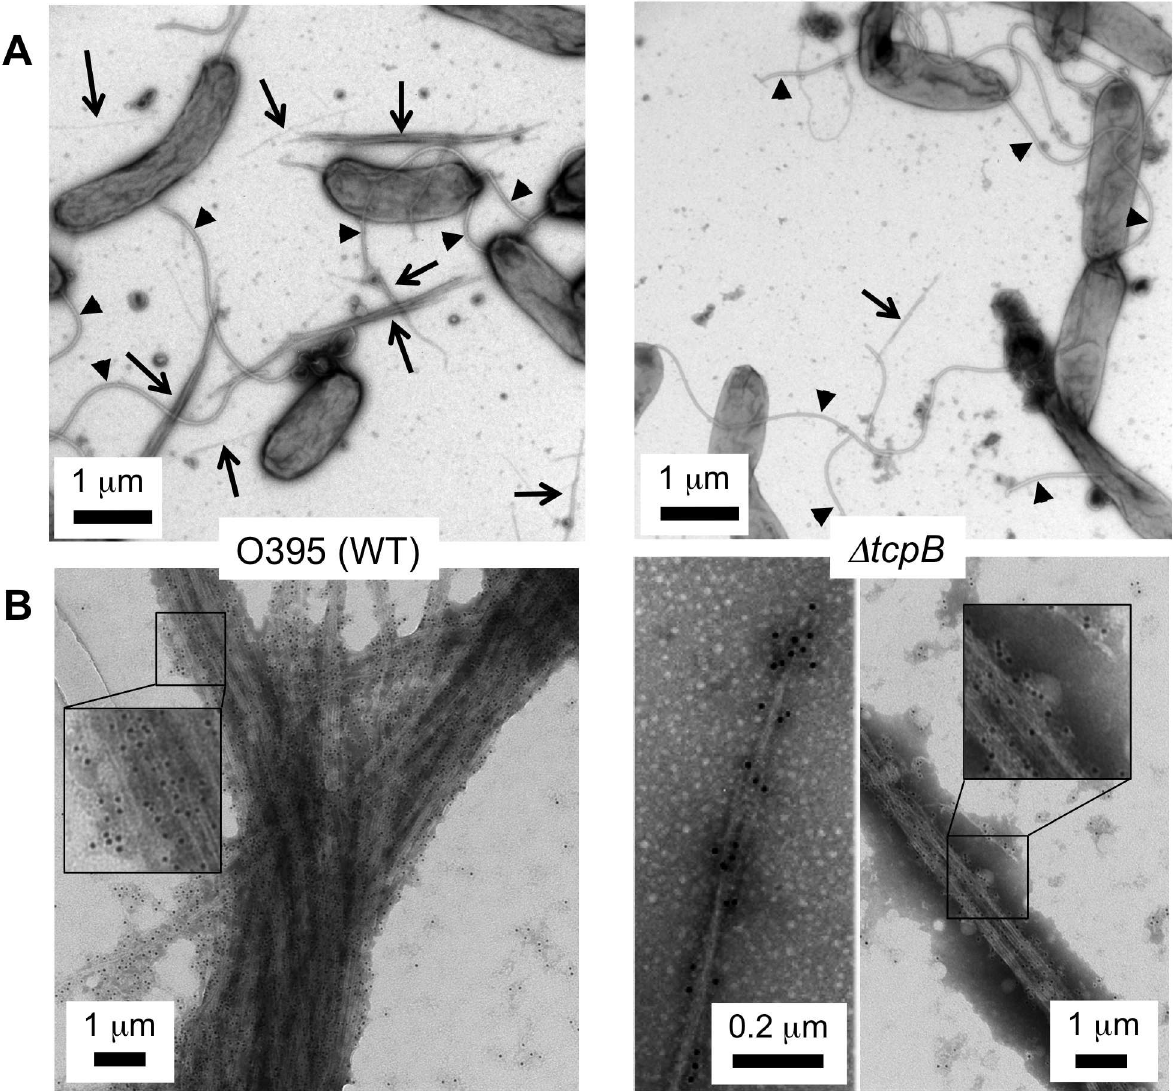
Fig 2. TCP are produced in very low numbers in the V . cholerae Δ tcpB strain. (A) The left TEM image is representative of WT O395, in which TCP bundlesare abundant, indicatedby arrows. In contrast, very few TCP bundlesare observedfor the Δ tcpB strain. One small bundleis shown in the image on the right. Flagellaare indicatedwith arrowheads. (B) TEM images of TCP labeledwith anti-TcpA primary antibody and gold-labeled secondary antibody.The gold particles are 6 nm in diameter. A section of each image is magnifiedin the inset to show the gold particles attached to the